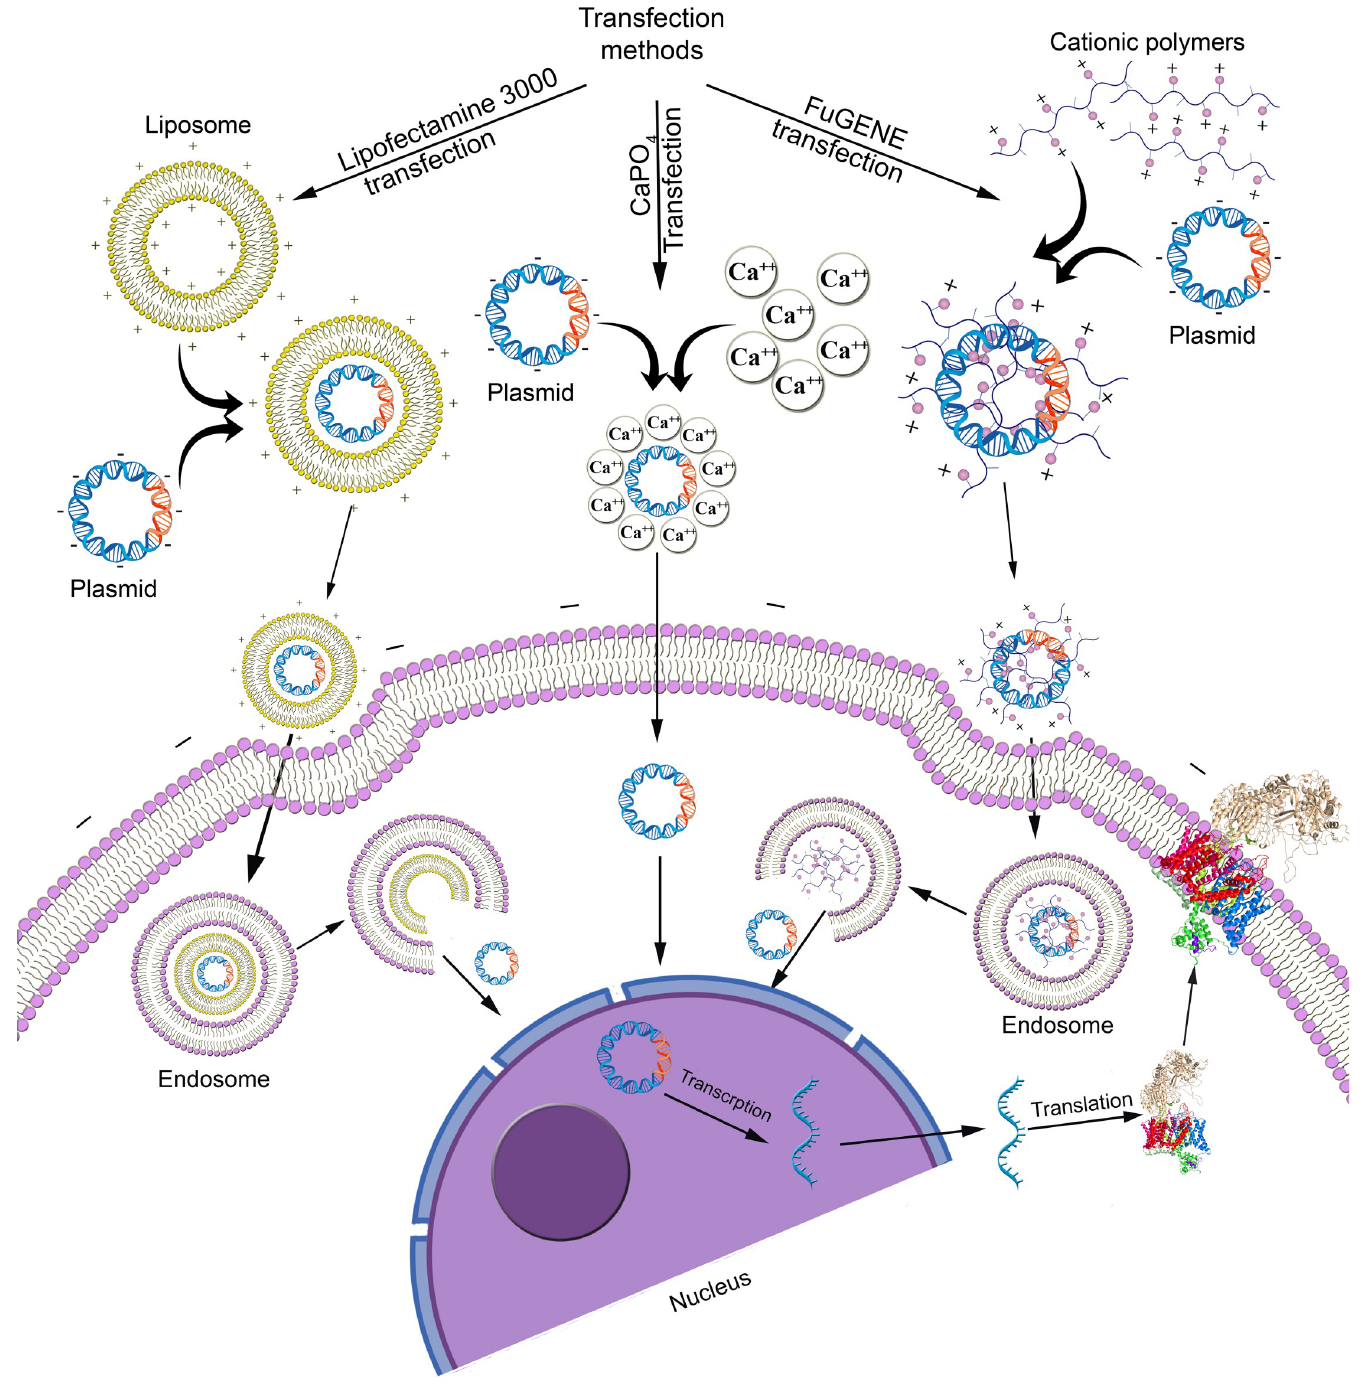
Fig 1. Comparison of chemical